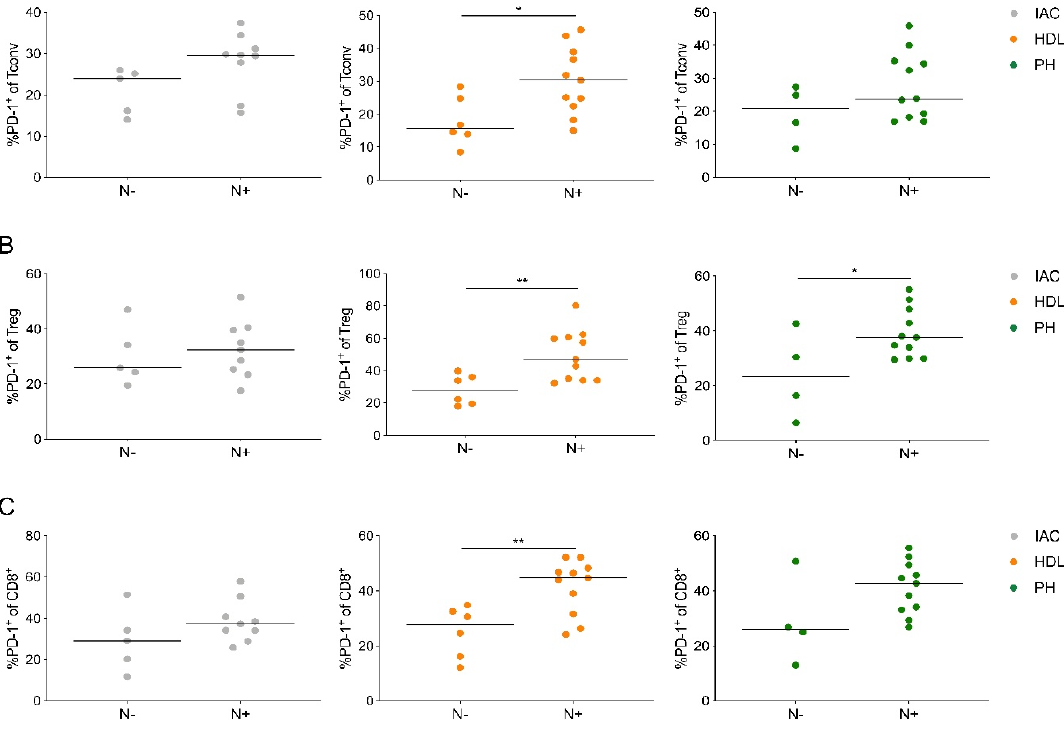
Figure 5. PD-1-expressing lymph node T cells are associated with node-positive PDAC. ( A ) Quantification of the expression of PD-1 on CD4 + Tconv cells (Tconv), ( B ) regulatory T cells (Treg) and (C) CD8 + T cells (CD8 + ) based on nodal stage (N-, negative; N+, positive). IAC, interaortocaval; HDL, hepatoduodenal ligament; PH, pancreatic head. Each point represents data from one patient. Data, median. Unpaired t -test. * p < 0.05, ** p ≤